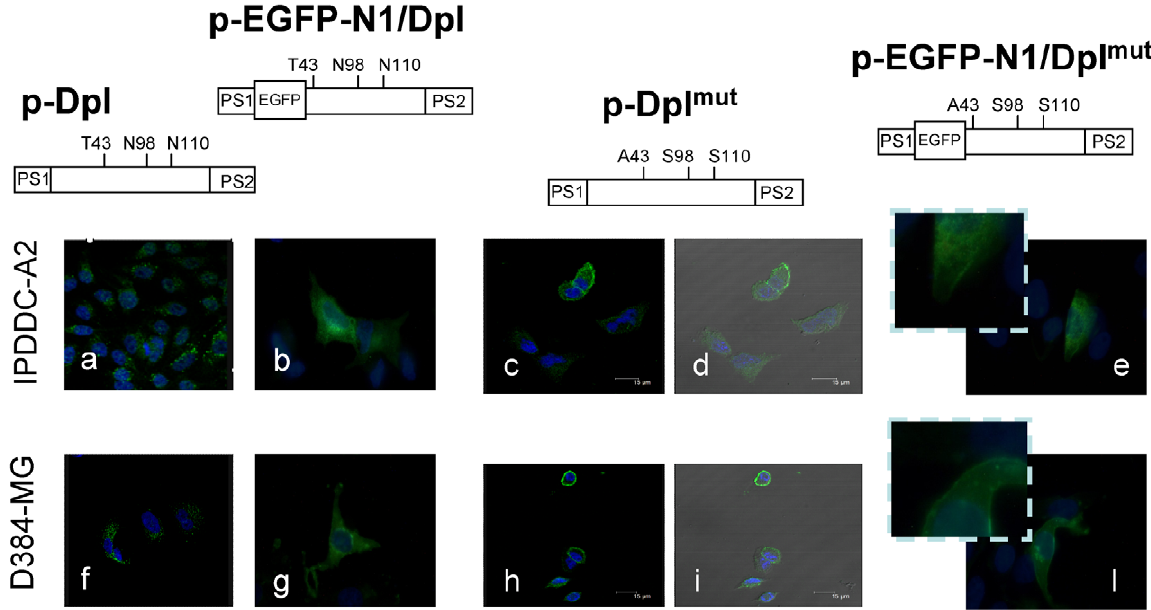
Fig. 4. Dpl transfection in astrocytoma cells. IPDDC-A2 and D384-MG cells (5 × 10 5 onto 30 mm dishes) were transfected with 1 µg of p-Dpl, pEGFP-N1/Dpl, p-Dpl mut or pEGFP-N1/Dpl mut expression vectors, combined with 2.5 µl of Lipofectamine 2000 (Invitrogen) as a transfection agent. After 24 hours post-transfection the medium was changed and the following day the cells were fixed on glass slides. Single immunofluores- cence reactions were performed using G-20 anti-Dpl goat polyclonal (Santa Cruz Biotechnologies) and Alexa Fluor 488 (Invitrogen) antibodies. In pEGFP-N1/Dpl and pEGFP-N1/Dpl mut transfected cells, EGFP was excited at 488 nm wavelength. IPDDC-A2 and D384-MG cells showed a diffuse cytoplasmic Dpl expression after p-Dpl and pEGFP-N1/Dpl transfection (respectively, panels a, b; f, g) while a plasma membrane Dpl lo- calization was highlighted in p-Dpl mut and pEGFP-N1/Dpl mut transfected cells, after confocal or Normanski interference contrast examinations (c, d, e; h, i, l). Cells were visualized with a confocal fluorescence microscope (Leica, original magnification, 63 × ). The scale bars are